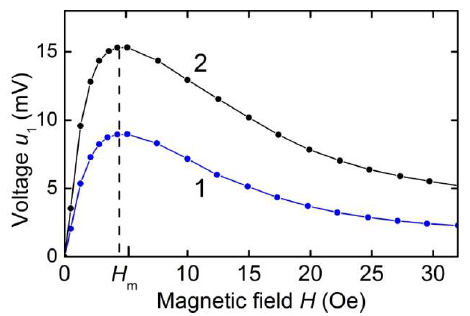
Figure 11. Dependence of ME voltage u 1 on the field H under the structure excitation at resonance frequency by a strip with a current (1) and a volumetric coil (2).